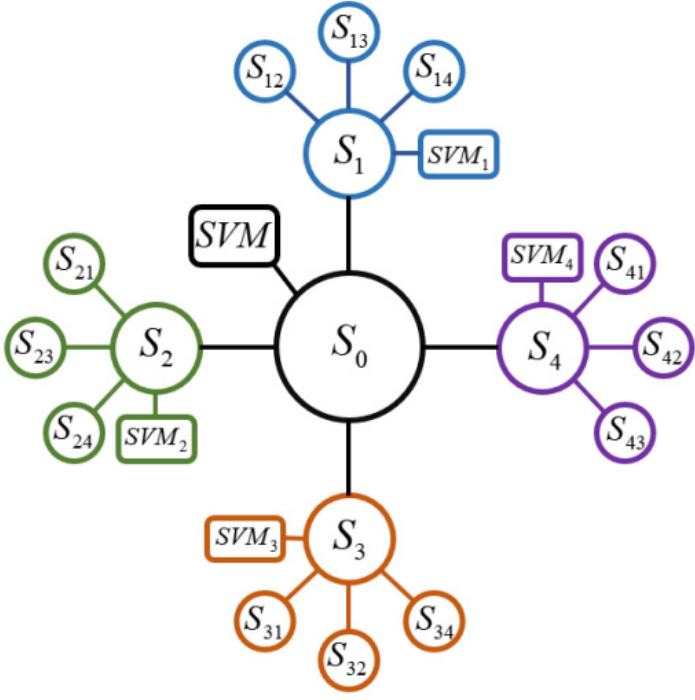
Figure 6. SVM-MM framework for multiple-fault diagnosis.